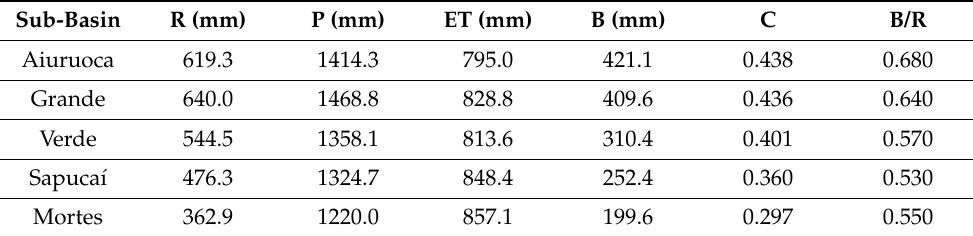
Table 2. Basic hydrological indicators for the main sub-basins upstream of the Furnas reservoir with fluviometric gauges.